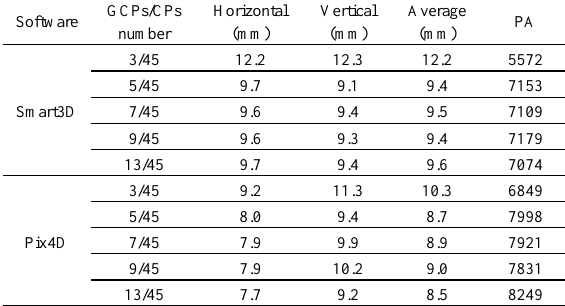
Table 4. Horizontal and vertical accuracies (H = 100 m)